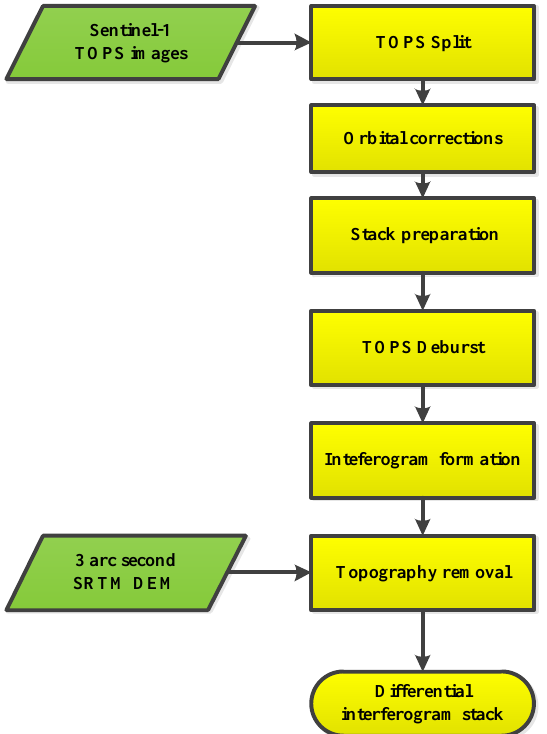
Figure 2. SNAP workflow for preparation of differential interferogram